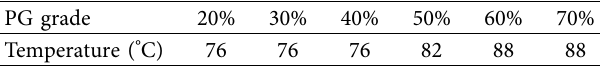
Table 5: PG grade test results of RTFOT-aged